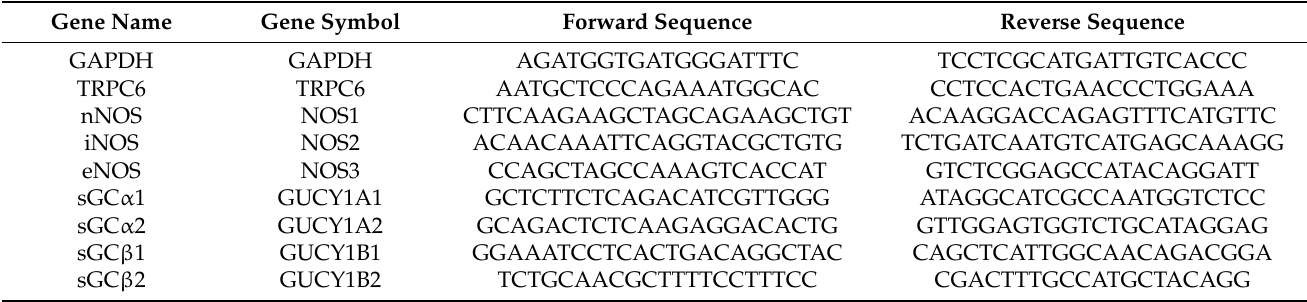
Table 1. List of gene-specific primers used in this